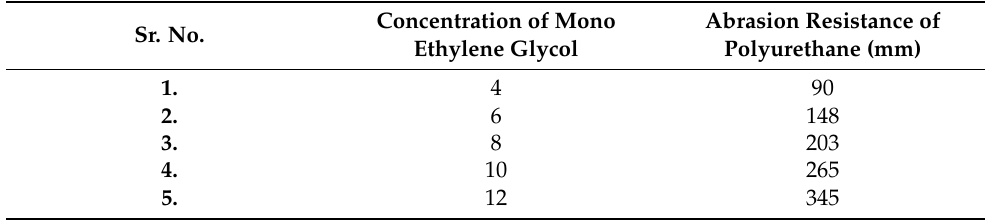
Table 6. Abrasion resistance of the polyurethane at different concentrations of mono ethylene glycol. Concentration of Mono Abrasion Resistance of Sr. No. Ethylene Glycol Polyurethane (mm)